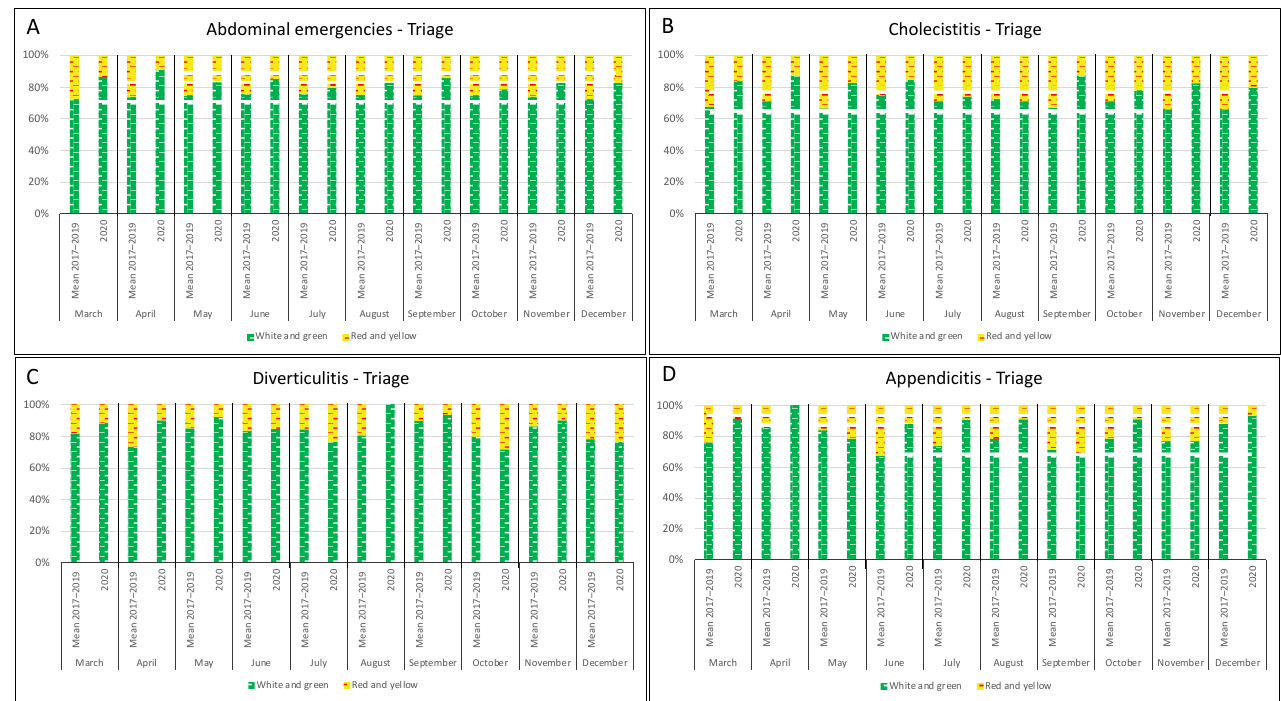
Figure 1. Monthly distribution of patients admitted to the ED for overall abdominal emergencies ( A ), cholecystitis ( B ), diverticulitis ( C ), and appendicitis ( D ) according to the triage classification system: comparison between the 2017–2019 period and 2020.